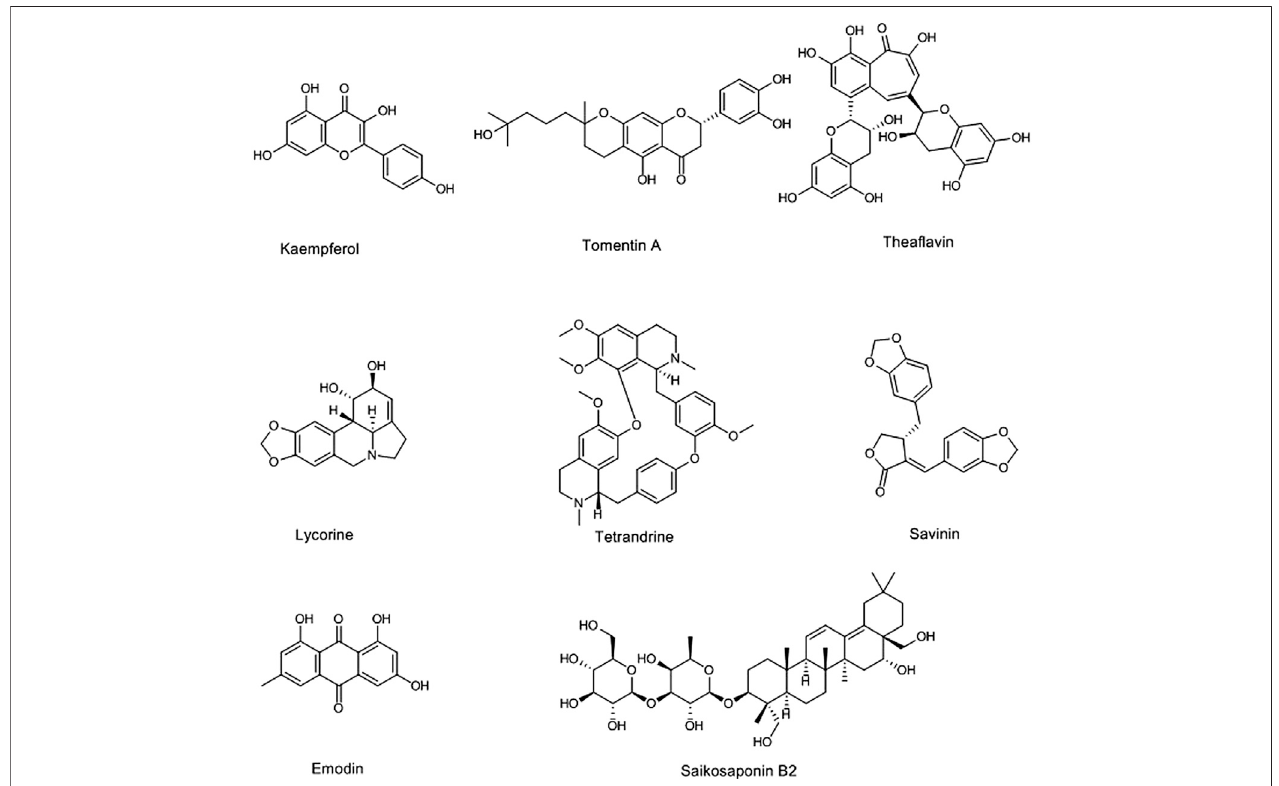
FIGURE 1 | Selected chemical structures of some phytochemicals with potential anti-CoV effects.